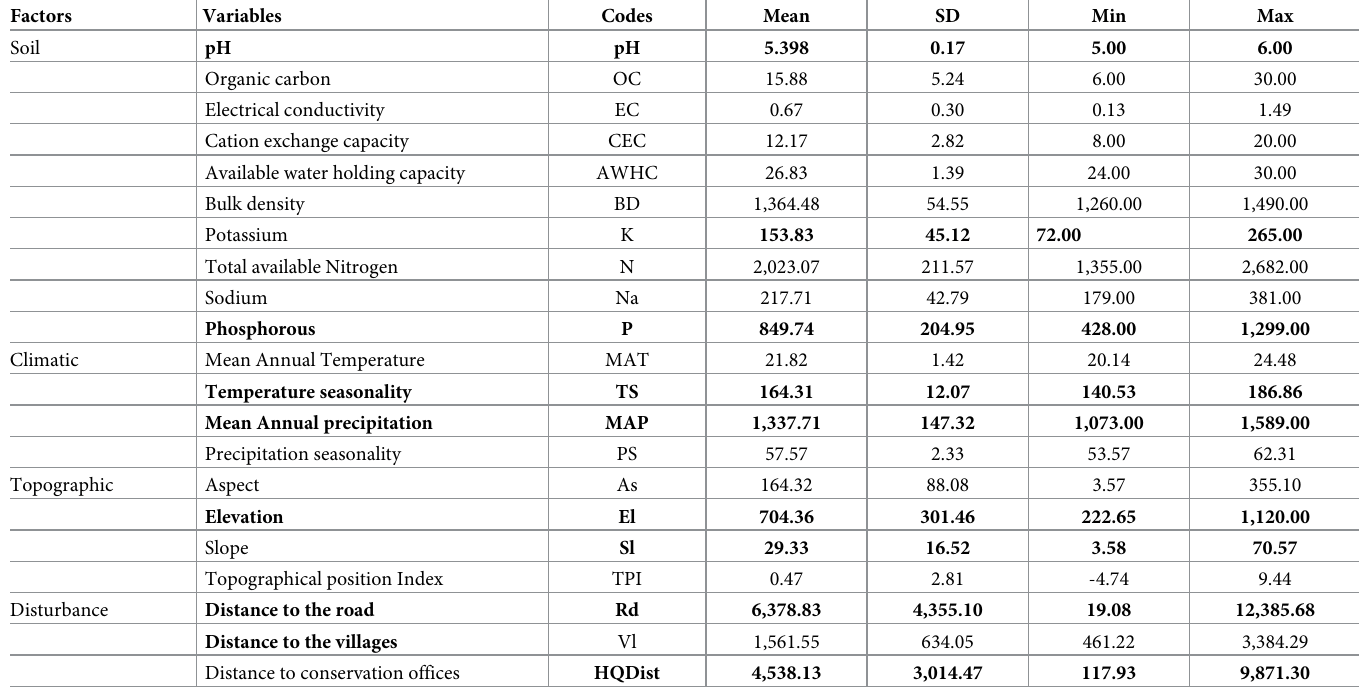
Table 1. The environmental and disturbance factors (Mean ± SD) within the tropical sub -montane forests of East Usambara, Tanzania. The bolded factors signifi- cantly explained species